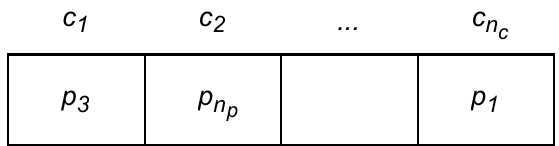
Figure 3. The vector representing the Academic